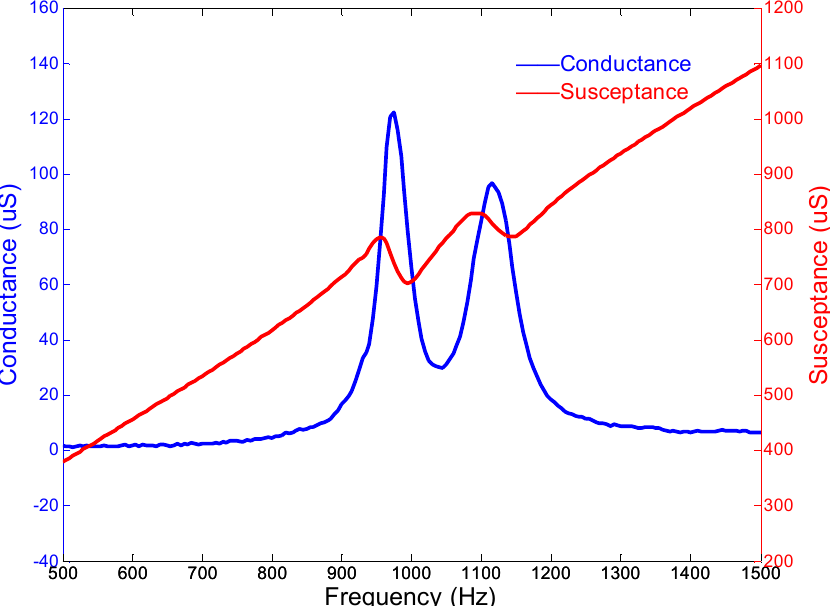
Figure 14. Admittance curves of four wired cascade-connected transducers (two for twelve segments and two for ten segments).